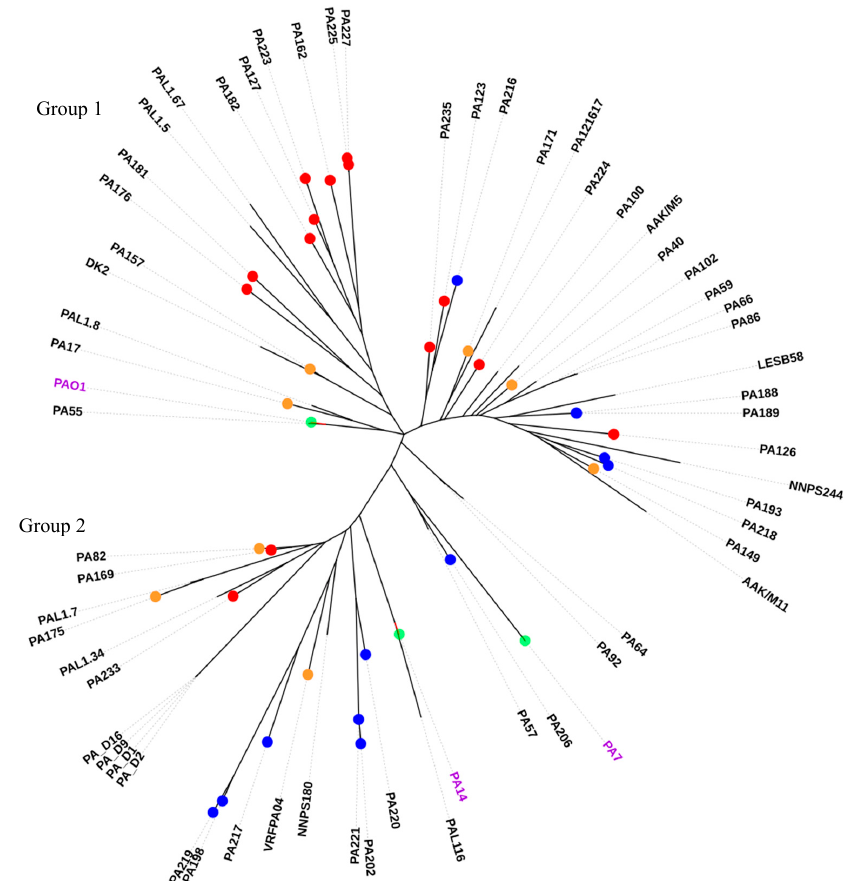
Figure 2. Pan genome phylogeny of P. aeruginosa isolates. Branches with no color representation indicate non-ocular isolates. Red color indicates Australian, blue color represents Indian, and orange color represents published eye isolates. Green color represents reference strains. Purple color represents reference strains .